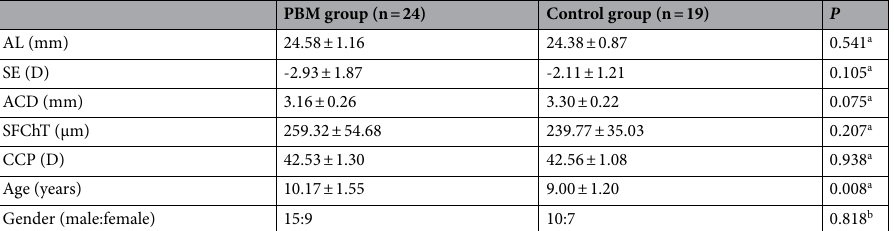
Table 1. Baseline parameters of PBM and control groups. AL axial length, SER spherical equivalent of refractive error, ACD anterior chamber depth, SFChT subfoveal choroidal thickness, CCP central cornea power, PBM group photobiomodulation therapy group, Control group single-vision spectacles group. The P values were determined by the independent samples. a t-test of the two groups, with the exception of gender, for which the b Chi-square test was used.